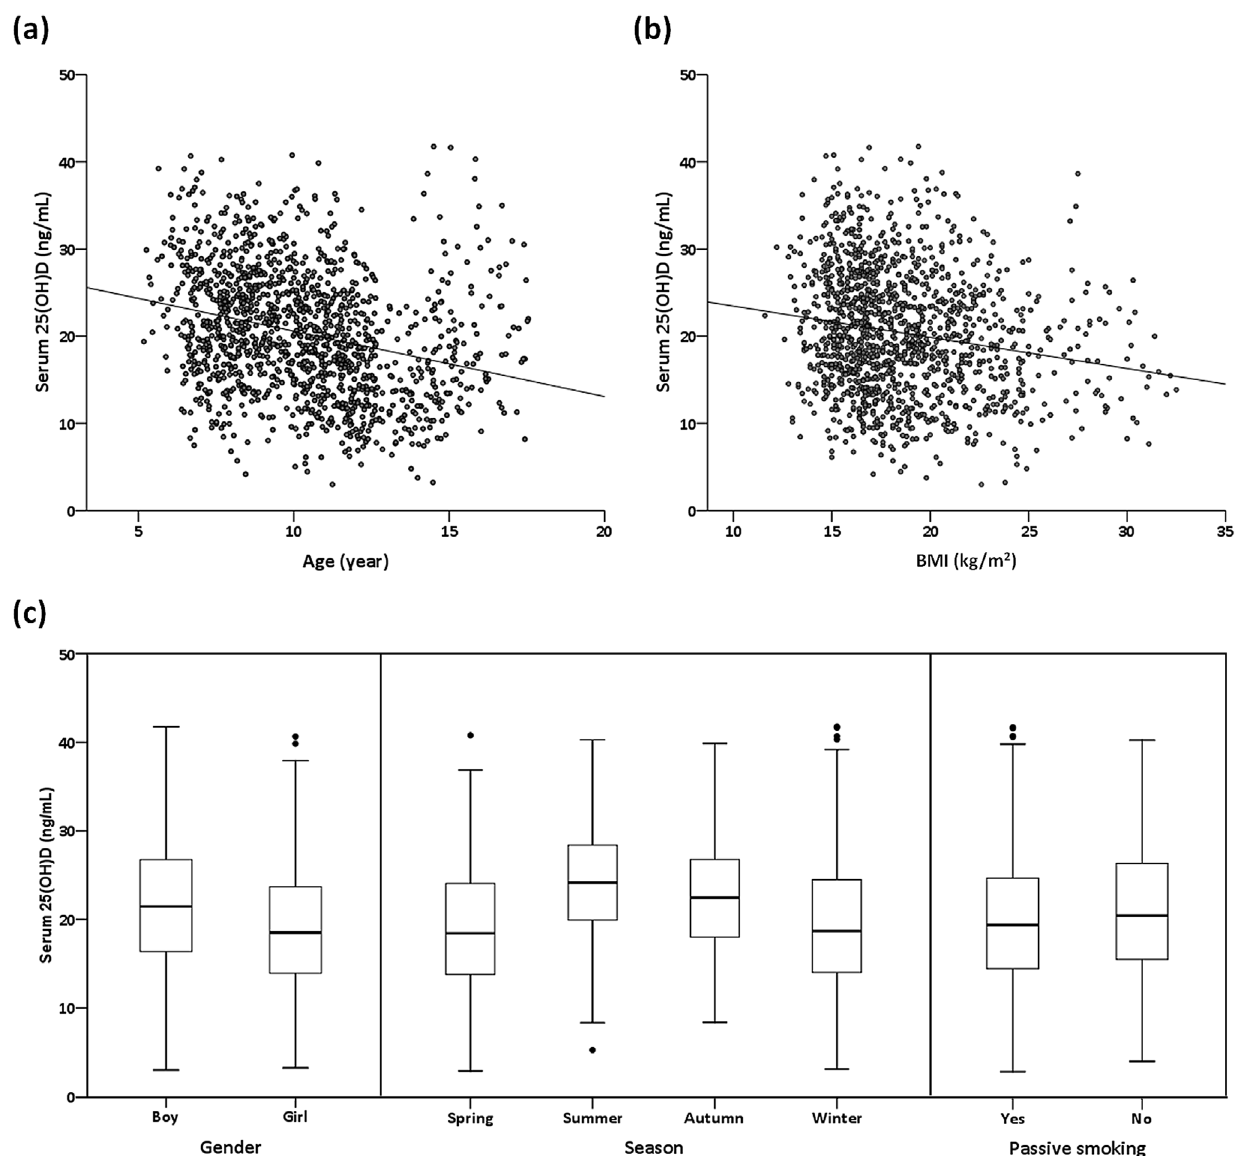
Figure 3. Serum 25(OH)D levels by (a) age ( r = 2 0.273, P , 0.001), (b) body mass index ( r = 2 0.179, P , 0.001), and (c) gender ( P , 0.001), season of sampling ( P , 0.001), and passive smoking ( P